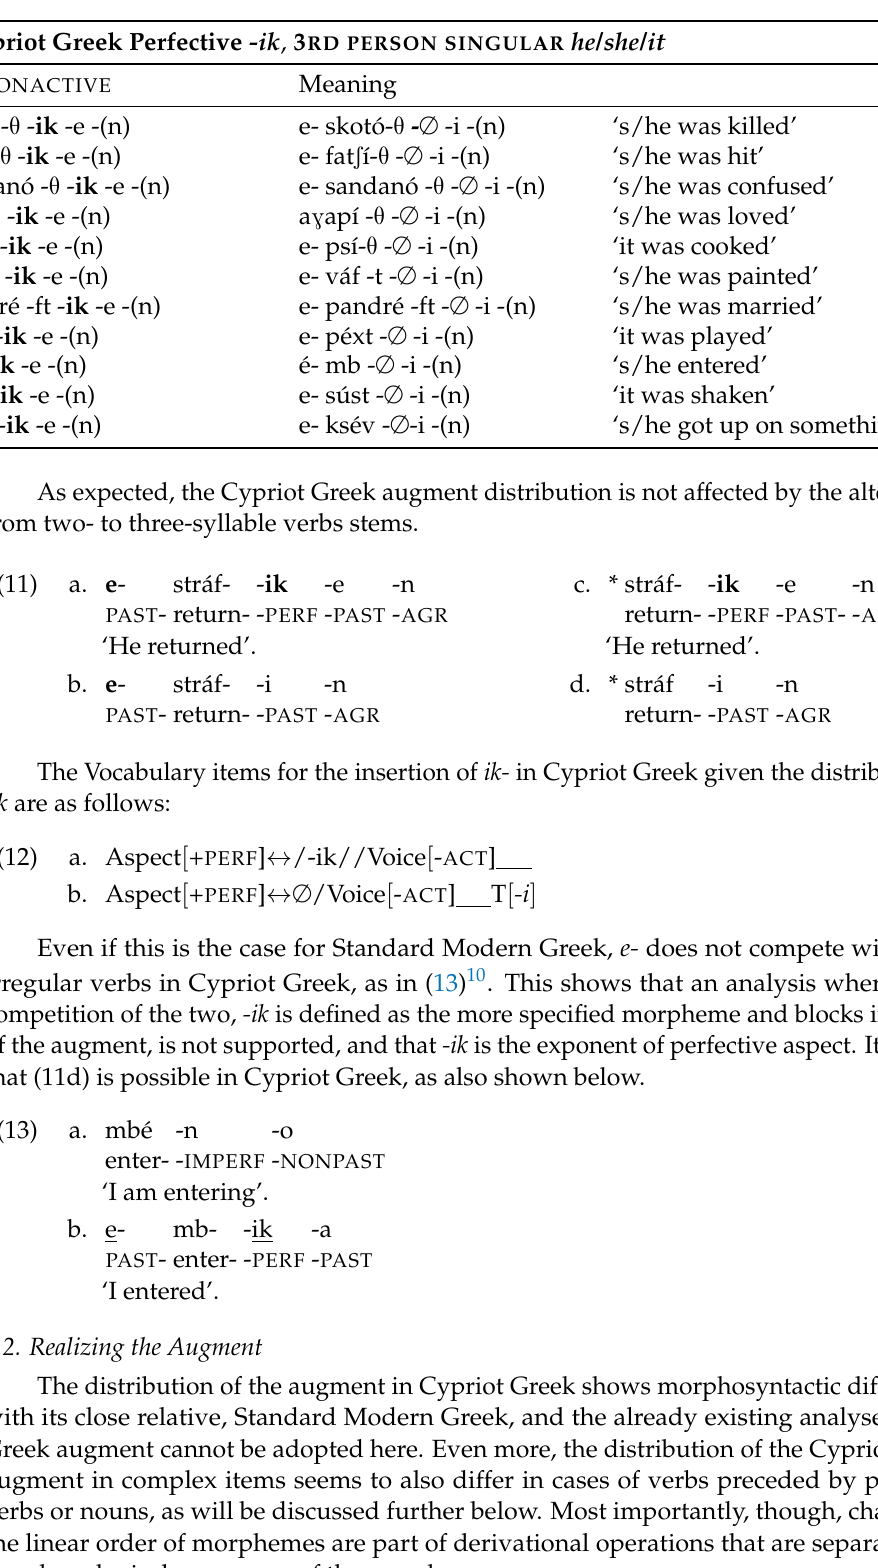
Table 3. The perfective -ik in 3 RD P ERSON S INGULAR